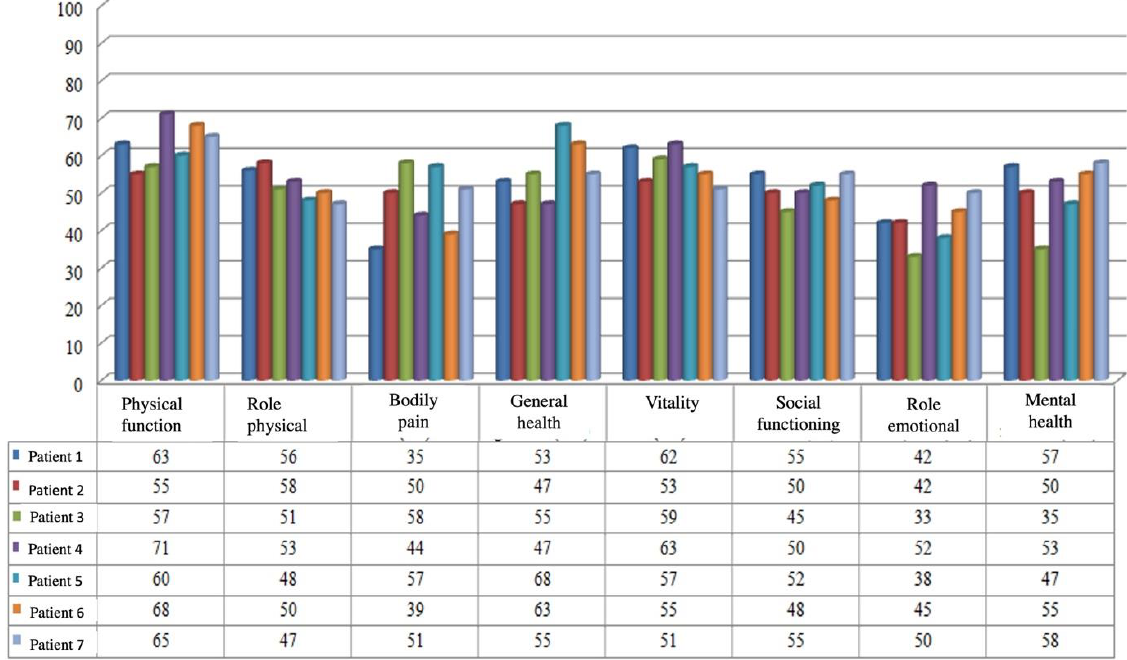
Figure 3. Results of SF-36 questionnaire.